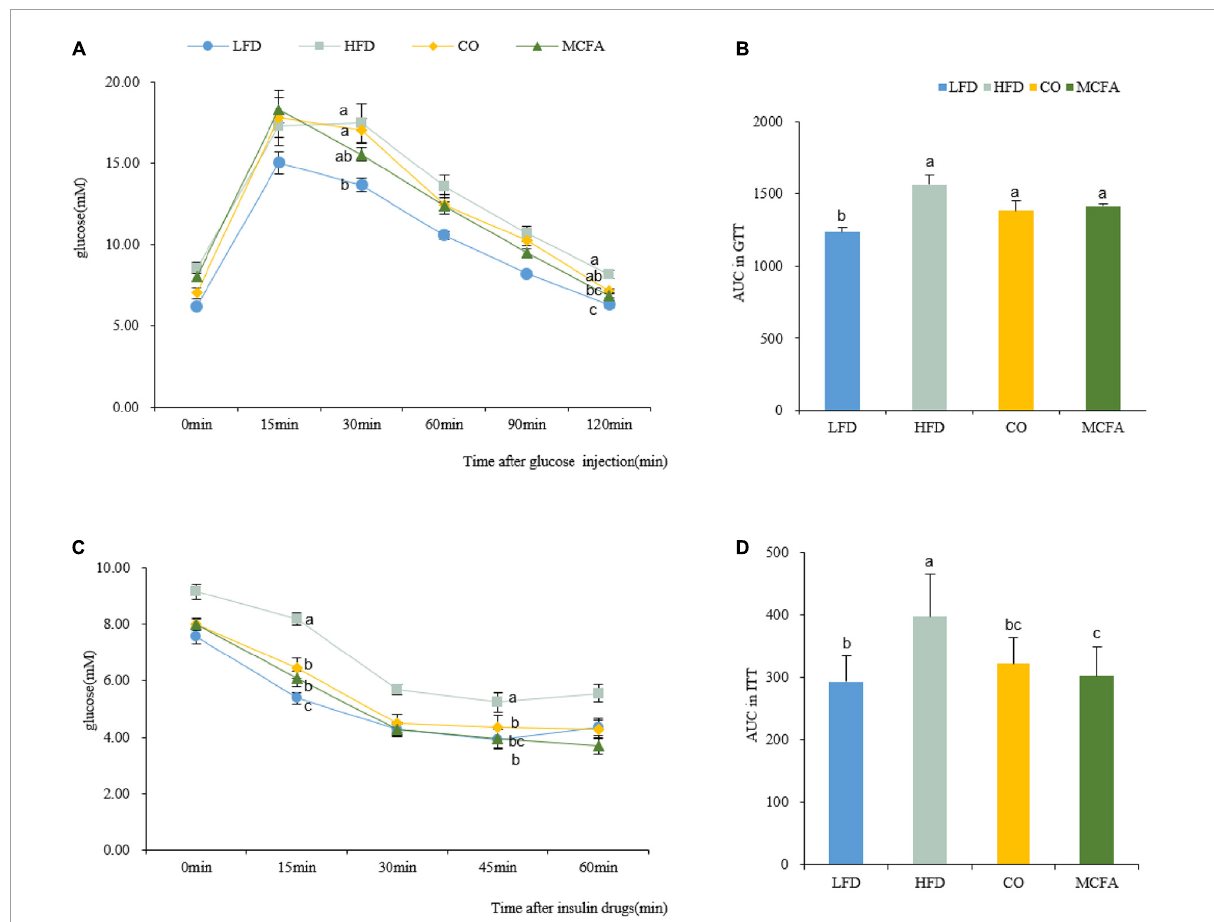
FIGURE2 CO and MCFA ameliorate glucose tolerance and insulin sensitivity. (A) GTT performed on the LFD, HFD, CO + HFD, and MCFA + HFD mice (injected with 2.5 U glucose per kg after a 16 h fast) ( n = 8–12). (B) Average area under the curve (AUC) ( n = 8–12). (C) The ITT was evaluated based on injection with 0.8 U insulin per kg after 6 h of fasting ( n = 8–12). (D) Average area under the curve (AUC) ( n = 8–12). Values represent means ± SEM. Mean values with different letters are significantly different ( P < 0.05).